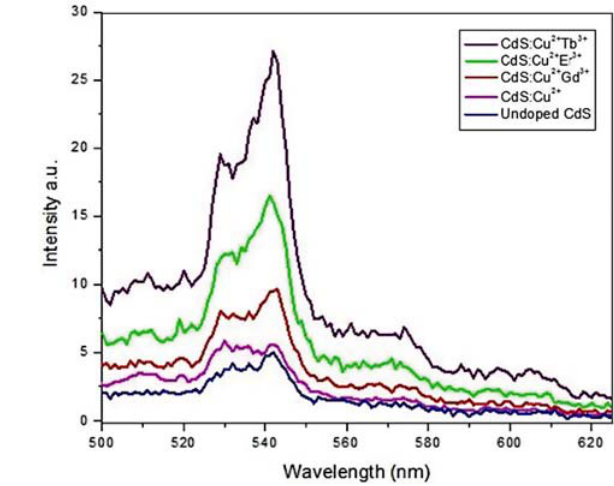
Figure 7. Photoluminescence spectra for (a) undoped CdS (b) Cd- S:Cu 2+ (c) CdS:Cu 2+ Gd 3+ (d) CdS:Cu 2+ Er 3+ (e) CdS:Cu 2+ Tb 3+